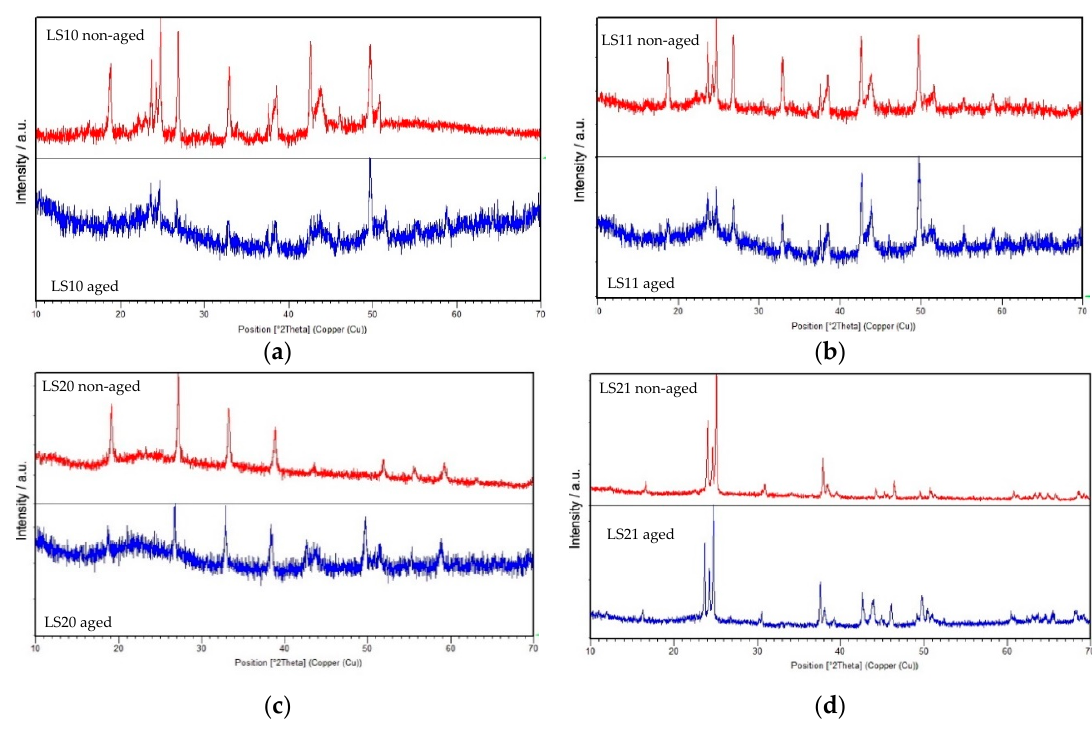
Figure 3. Diffractograms of samples ( a ) LS10, ( b ) LS11, ( c ) LS20, and ( d ) LS21. XRPD patterns colored in red are non-aged samples, whereas patterns colored in blue correspond to samples aged in the acetic acid.